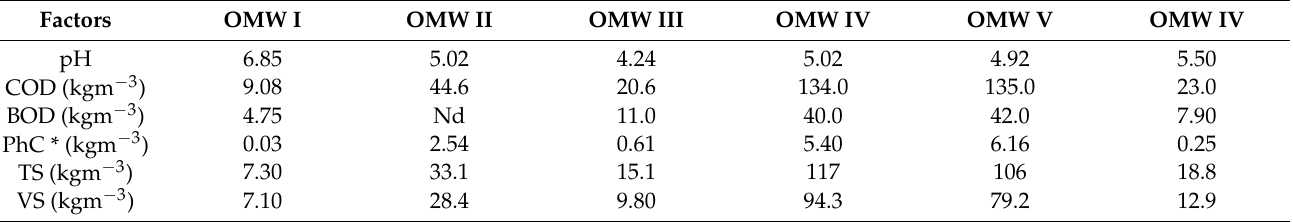
Table 1. Portuguese OMW characterization from 6 olive mills in the campaign. Adapted from Reference